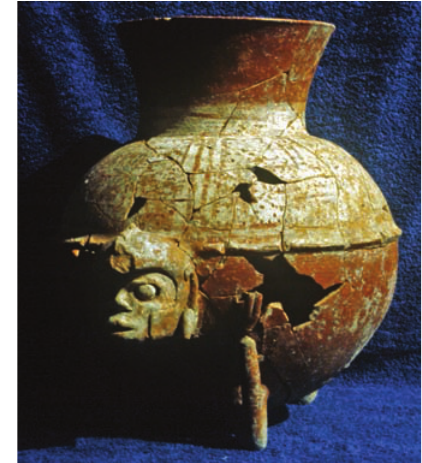
Figure 5 This vessel representing a monkey was found in the same tomb as the hunchback vessel.